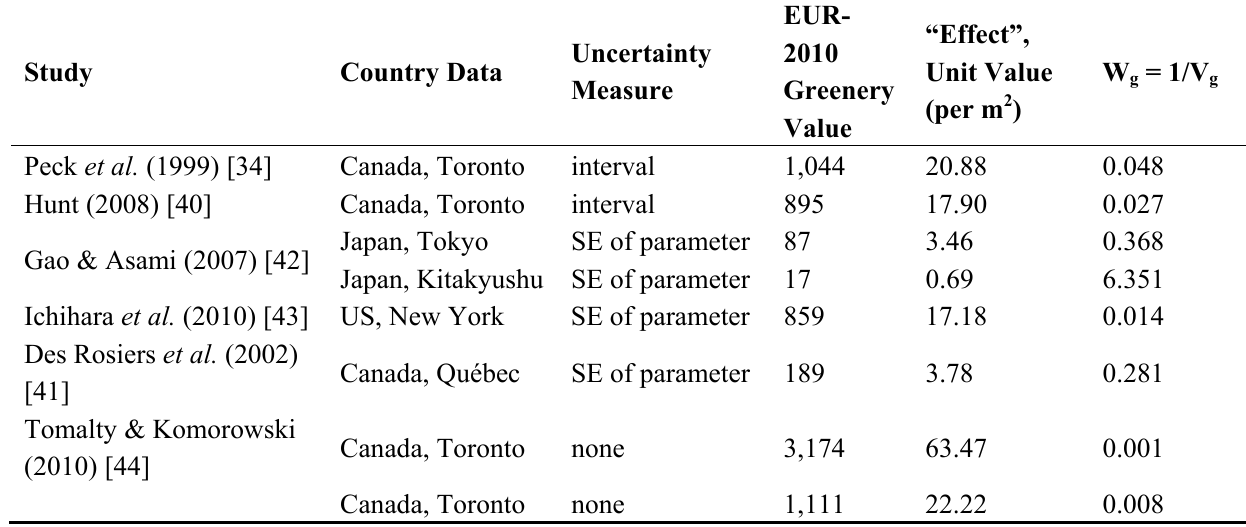
Table 2. Weighting of unit values, green roof/wall †